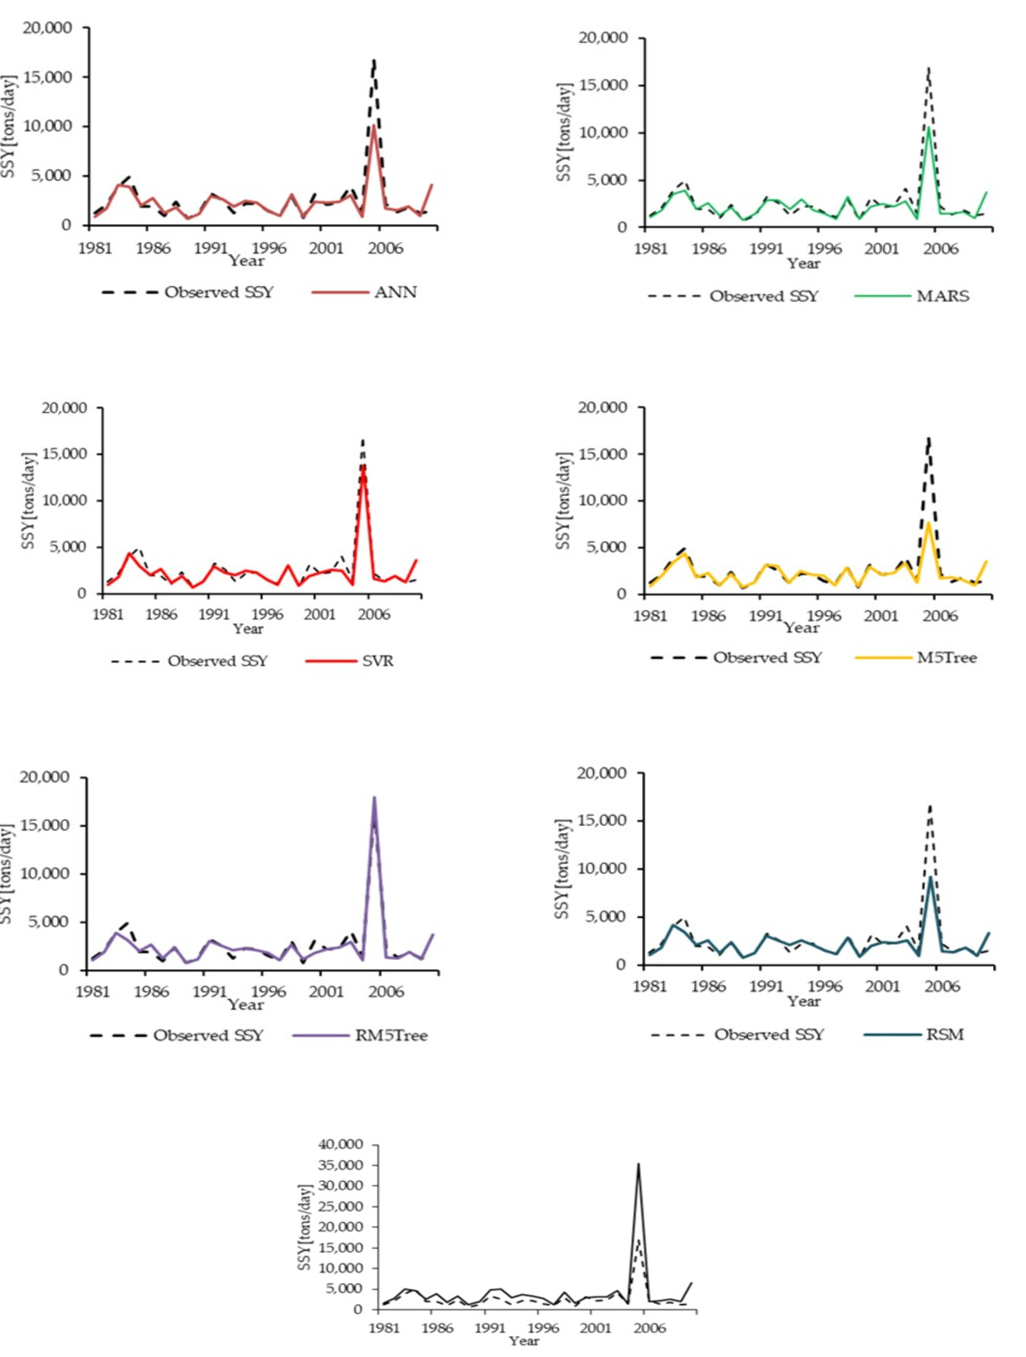
Figure 12. Time series plots of the observed and predicted SSYs that were found using the ANN, MARS, SVR, M5Tree, RM5Tree, RSM and SRC models.